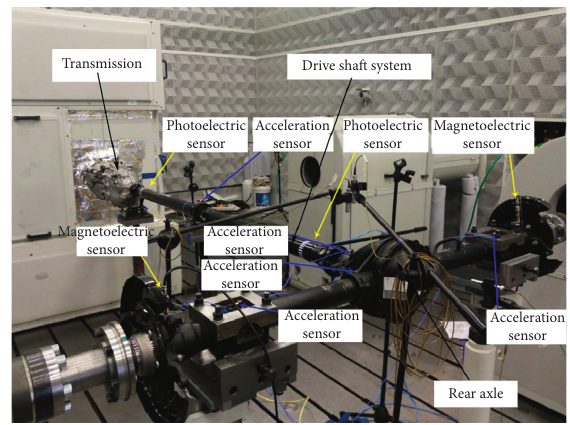
Figure 9: The experiment bench and arrangement of sensors.